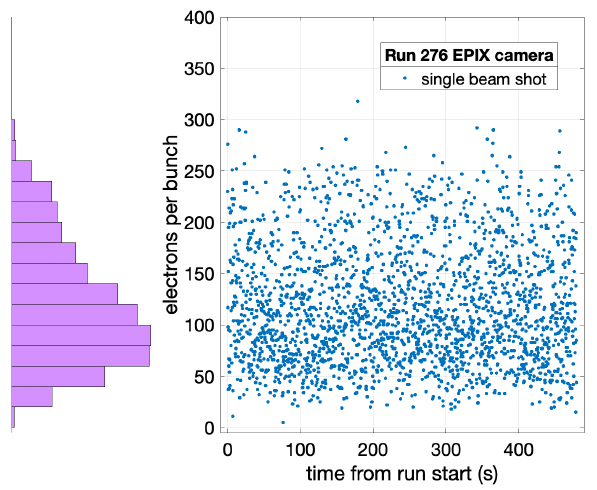
FIG. 7. For the same run shown in Fig. 6, we show the individual frame electron counts per bunch and a marginal histogram on the left, showing the